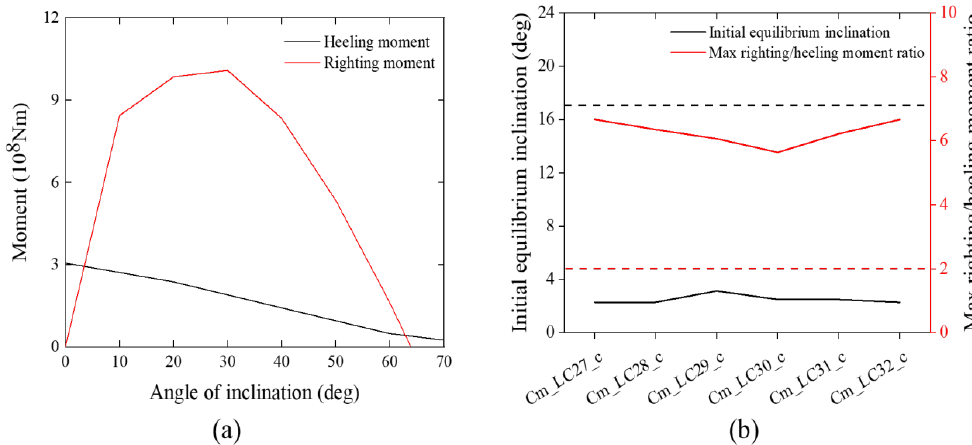
Figure 7. Stability analysis results. ( a ) The righting moment and heeling moment for intact stability check. ( b ) The ratio between the maximum ratio between the righting and heeling moments (red) and initial equilibrium inclination (black) for different damaged compartments.